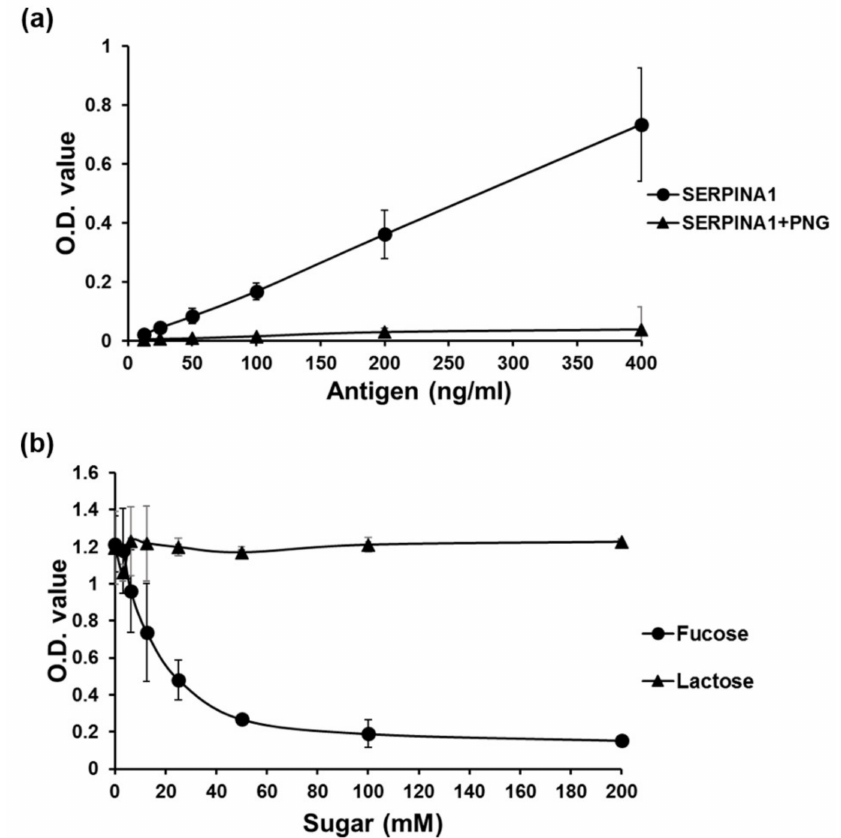
Figure 5. Evaluation of the specificity of AAL binding to fuco-SERPINA1 in reverse lectin ELISA. ( a ) Different amounts of recombinant SERPINA1 protein were treated with or without PNGase F (PNG) (protein:PNGase F = 1 µ g:1U, 37 ◦ C for 20 h) and subjected to AAL-based reverse lectin ELISA. ( b ) AAL was pre-incubated with different doses of L-fucose or lactose at room temperature for 0.5 h and coated onto ELISA plates. Plates were subjected to reverse lectin ELISA for detecting fixed amounts of fuco-SERPINA1. OD values were measured at 450 nm and each data point was examined in duplicate. Data expressed as mean ± S.D. are presented as a black solid